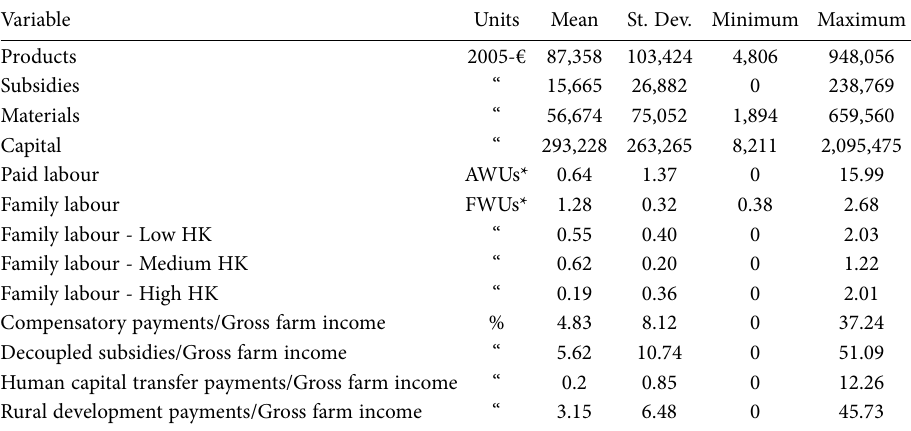
Table 2. Descriptive statistics of the main variables.